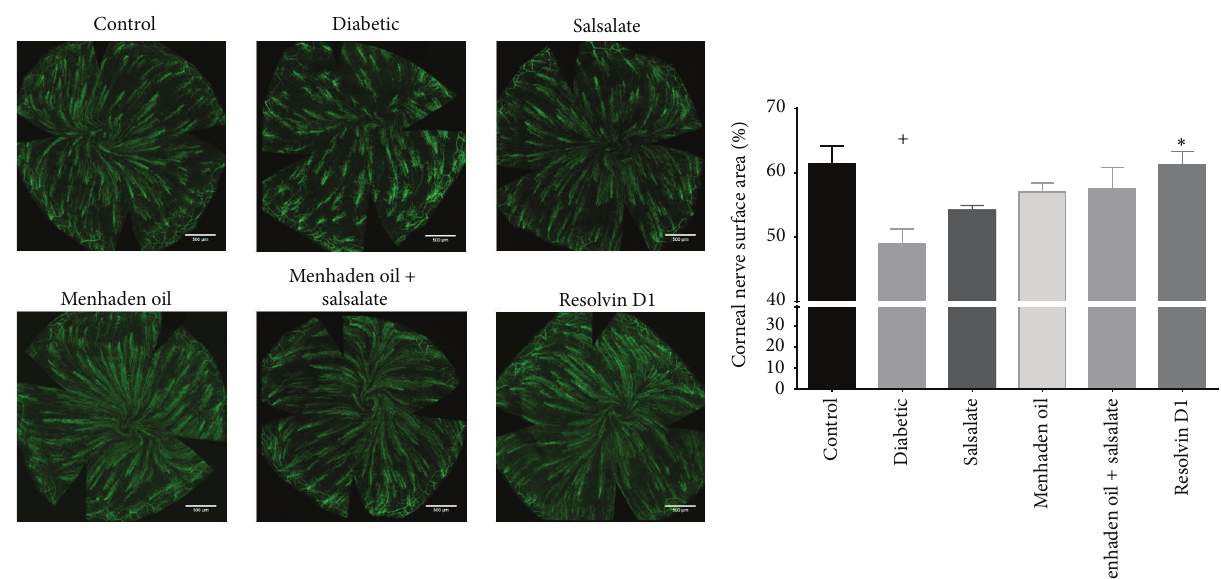
Figure 3: Immunohistochemical analysis of subepithelial corneal nerves using neuronal class 𝛽 -III tubulin. A maximum intensity projection image was acquired as described in the Materials and Methods. Corneal nerve surface area was determined using Imaris software and the effects of treatment can be seen in the graph. Data are presented as mean percentage of nerve coverage ± SEM relative to the area of the entire cornea. The number of animals per group was the same as described in Table 3. + 𝑝 < 0.05 compared to control group. ∗ 𝑝 < 0.05 compared to untreated diabetic